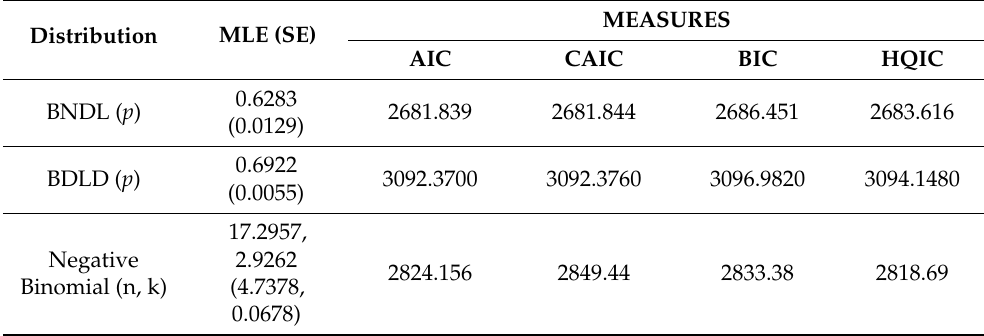
Table 3. MLEs and their standard errors (in parentheses) with statistics AIC, BIC, HQIC and CAIC values for given